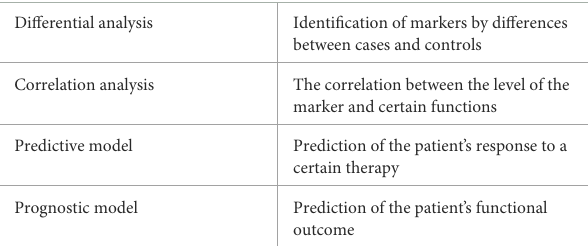
TABLE 1 General process of identifying